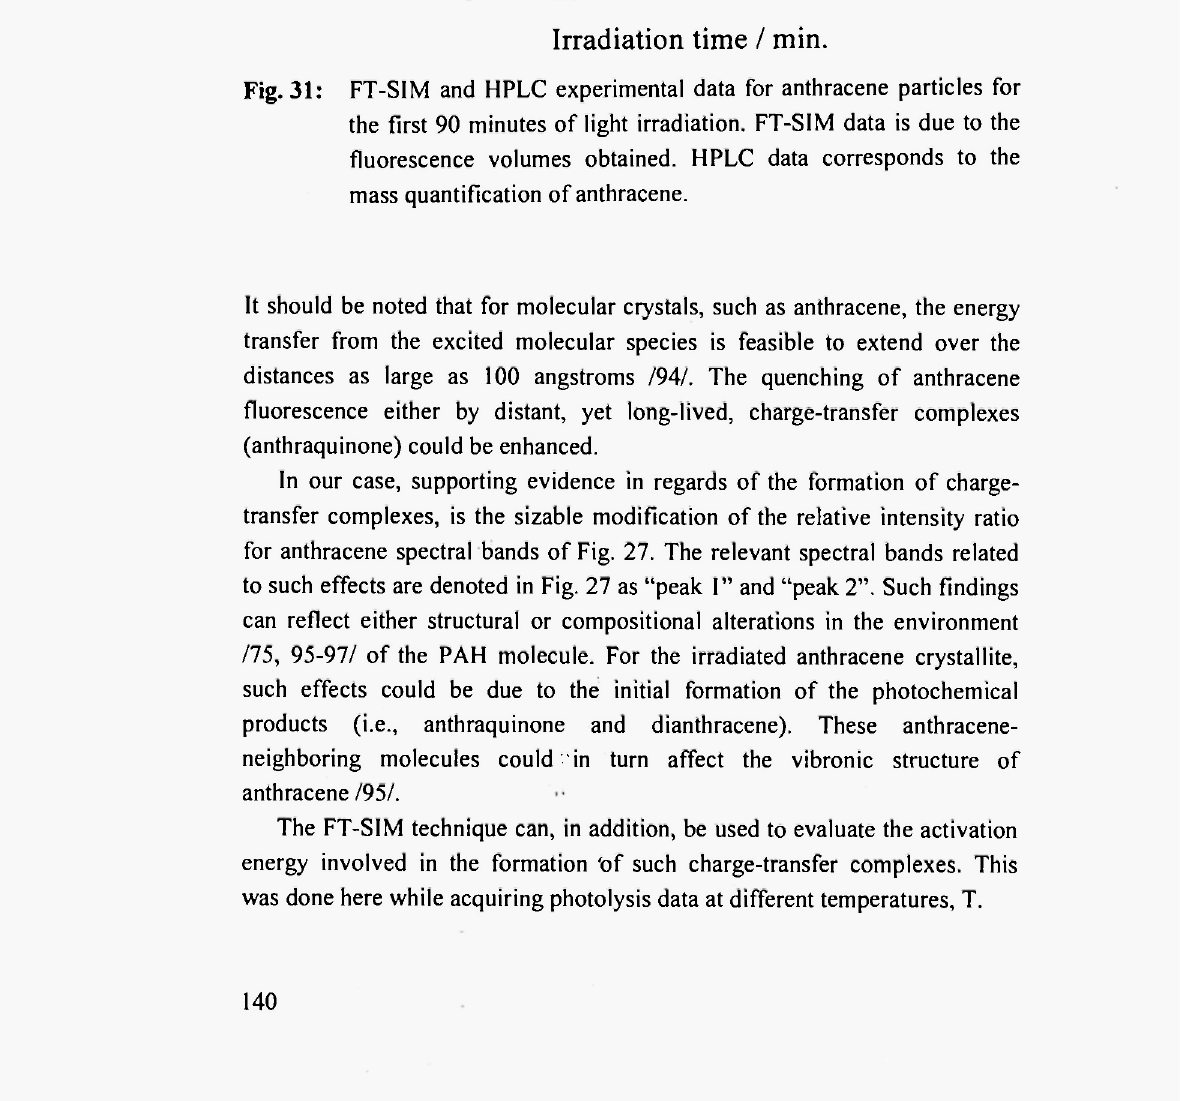
Fig. 31: FT-SIM and HPLC experimental data for anthracene particles for the first 90 minutes of light irradiation. FT-SIM data is due to the fluorescence volumes obtained. HPLC data corresponds to the mass quantification of